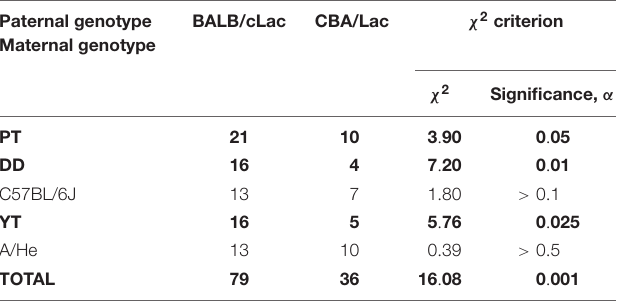
SNP markers for human social hierarchy [ Table 2 : p(H 0 : N ↑ = N ↓ = N RES /2) > 0.9]. This correspondence means that